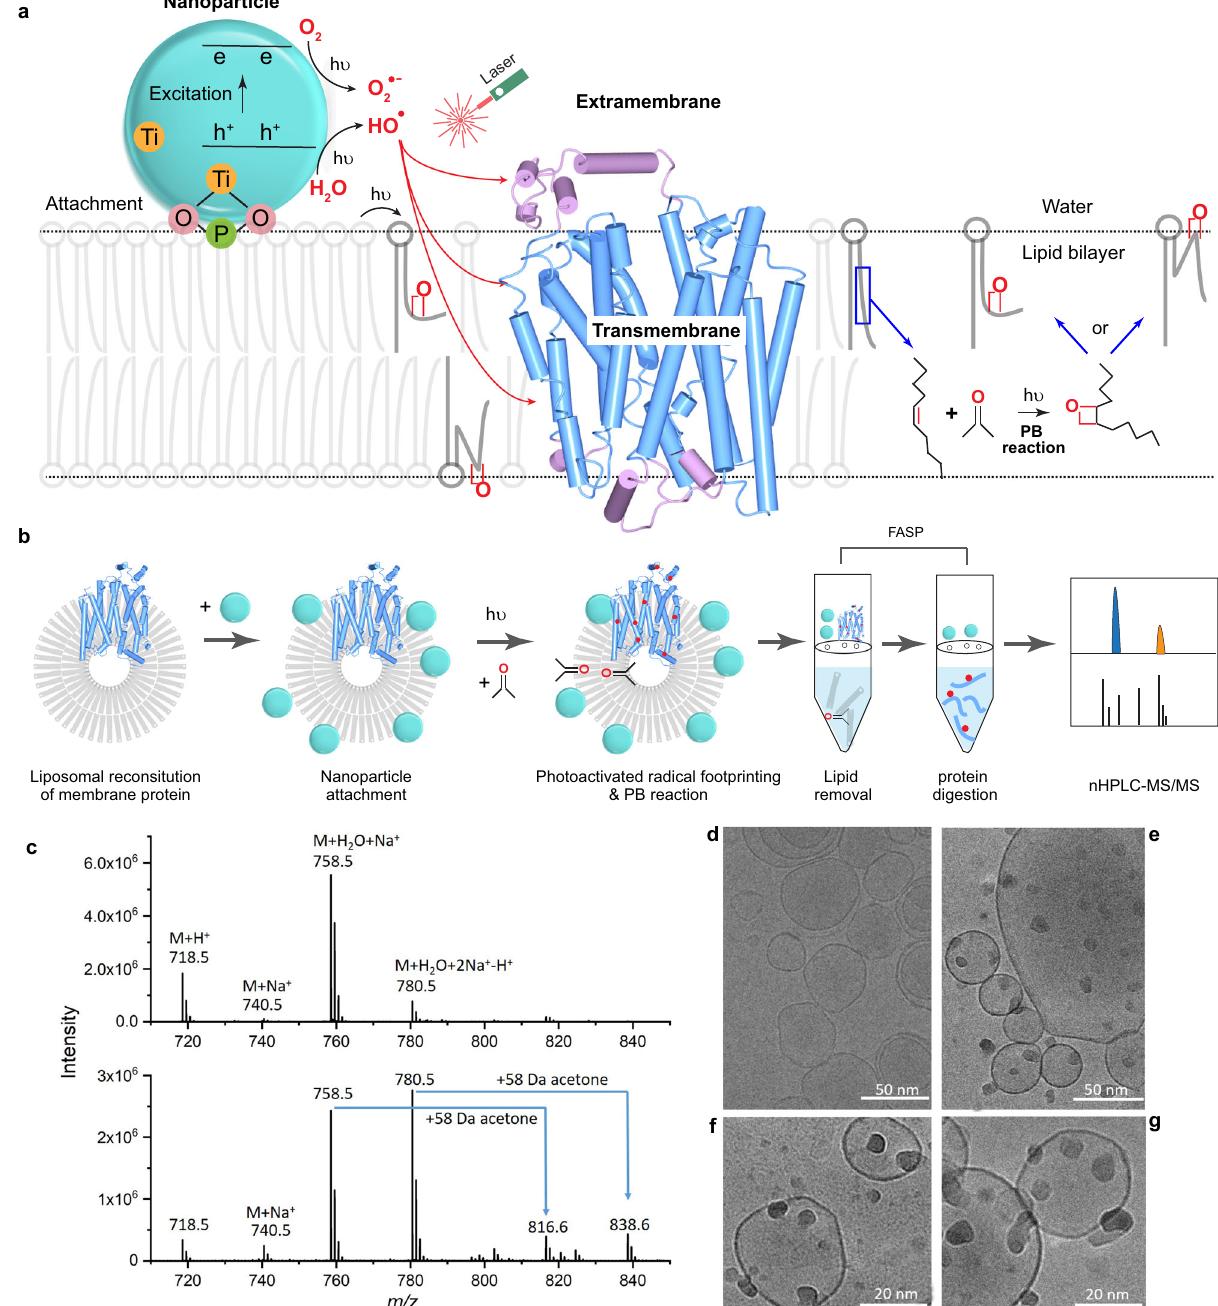
Fig. 1 Work fl ow and characterization of NanoPOMP. a Scheme of NanoPOMP for IMP stabilized in liposome. TiO 2 NPs are attached to the phosphate groups on the lipid bilayer. The liposome containing the IMP is irradiated with a 248nm KrF laser, generating radicals (red dots). The PB reaction of acetone and lipid double bonds generates kinks in bilayer by a reaction mechanism shown on the right. b Typical work fl ow for the NanoPOMP experiment. (Although the protein is positioned in both orientations with equal probability in a liposome, we show only one orientation as an example.) c Upper: zoomed ESI mass spectrum of POPE and acetone/H 2 O; lower: ESI mass spectrum of POPE and acetone/H 2 O induced by NanoPOMP laser. Source data are provided as a Source Data fi le. d Cryo-EM image of liposome. e – g Cryo-EM images of TiO 2 NPs (dark small spheres) attached to the liposome (large spheres), demonstrating liposome stability upon adsorption of NPs onto the surface. Higher magni fi cation is shown in ( f , g ) for different sections of a cryo- EM grid. Experiments of d – g are repeated twice independently with similiar In addition to the imaging of the TiO 2 NPs-POPE/POPG protrusion forces 31 . The size of the NPs play a role in the liposome system, previous studies further support the view that interaction 32 – 34 , for example, 5 nm AuNPs (the particle diameter used here) have the smallest in fl uence on the membrane the NPs used here do not signi fi cantly affect the liposome compared to larger sizes 32 . In another case, suspensions of SiO 2 structure. The liposome/NP interaction includes van der Waals, NPs and DPPC liposomes are stable for months for mixtures of double layer, hydration, hydrophobic, thermal undulation, and